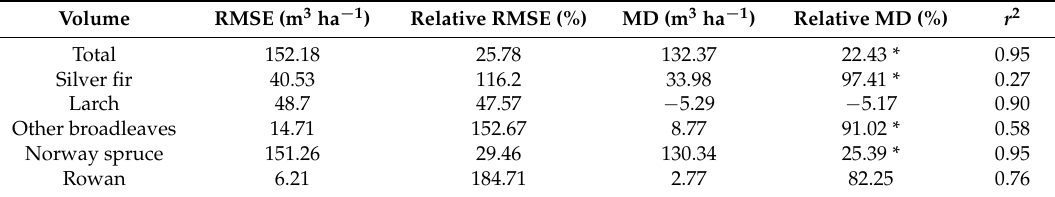
Table 4. Results of the predicted volumes derived from the ITC approach, aggregated to the plot level (* = differences between the predicted and observed volumes are significantly different from zero ( p ≤ 0.05), RMSE = root mean square error, and MD = mean differences).